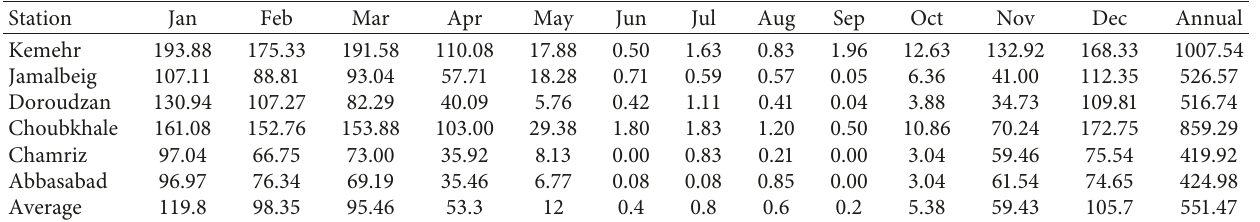
Table 3: The annual and monthly average of the precipitation of the Doroudzan catchment stations (mm).